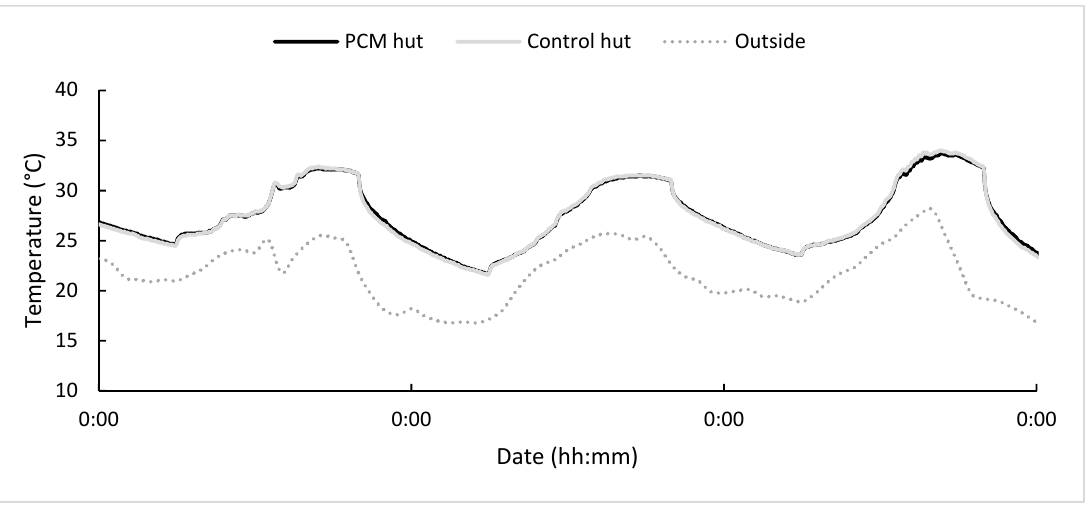
Figure 9. Temperature of the huts for consecutive summer days with hot nights.